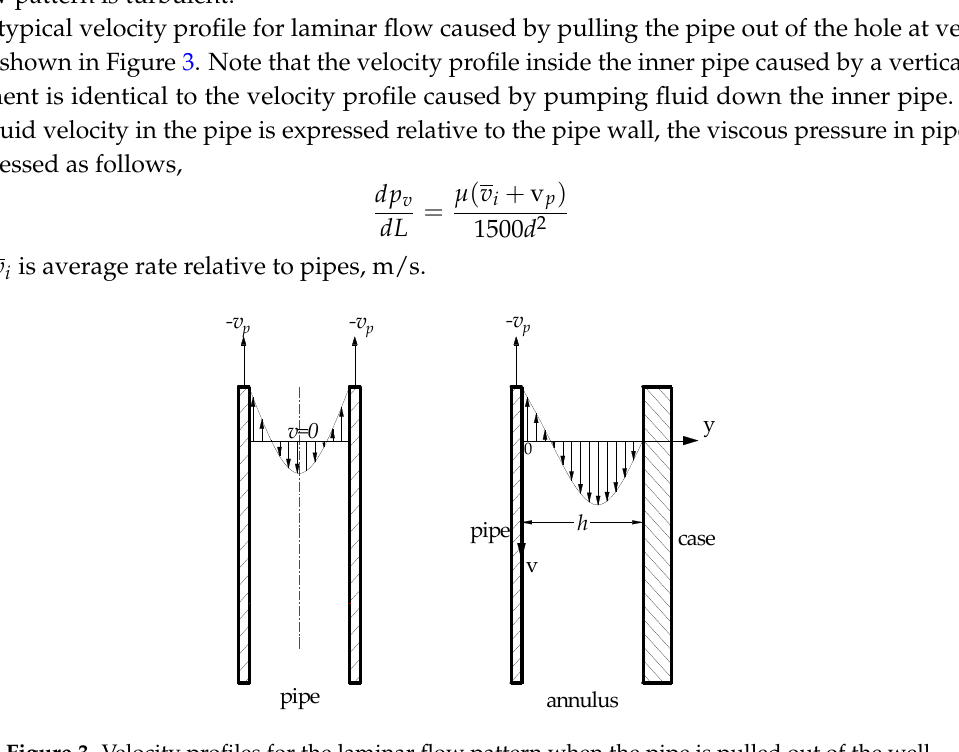
Figure 3. Velocity profiles for the laminar flow pattern when the pipe is pulled out of the